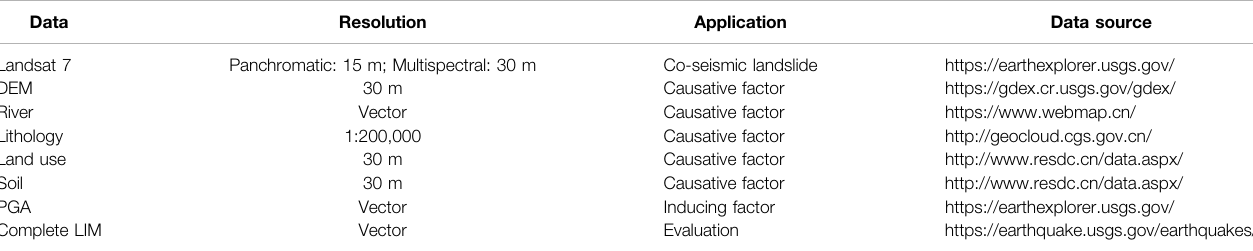
TABLE 1 | Data sources used in this